Question: Sum up the contents of this chart in one sentence.
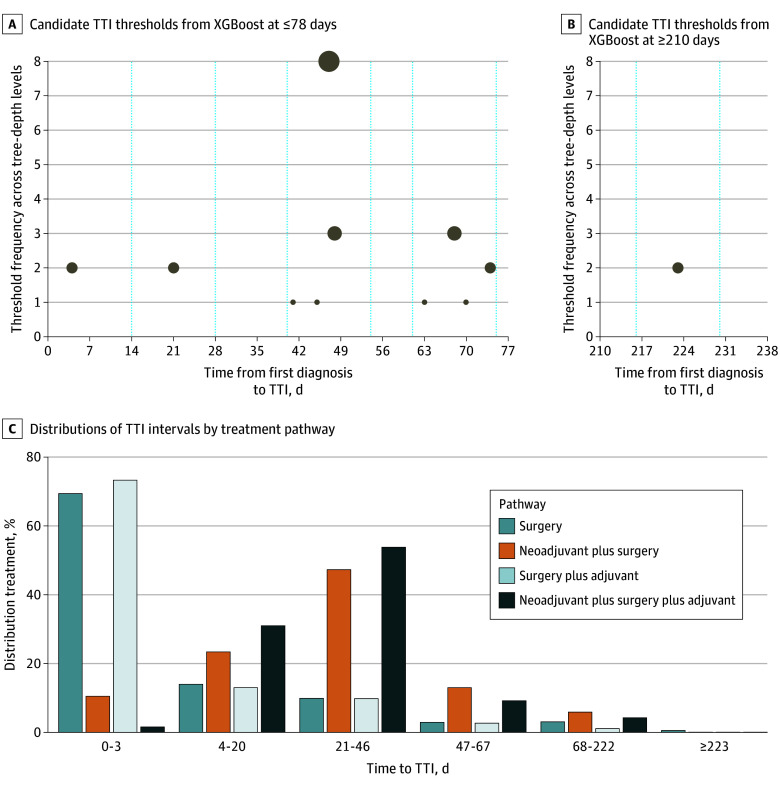
Answer: Time-to-Treatment Initiation (TTI) Thresholds and Their Distributions by Treatment Pathway The size of plotted circles indicate the threshold frequency across tree-depth level.